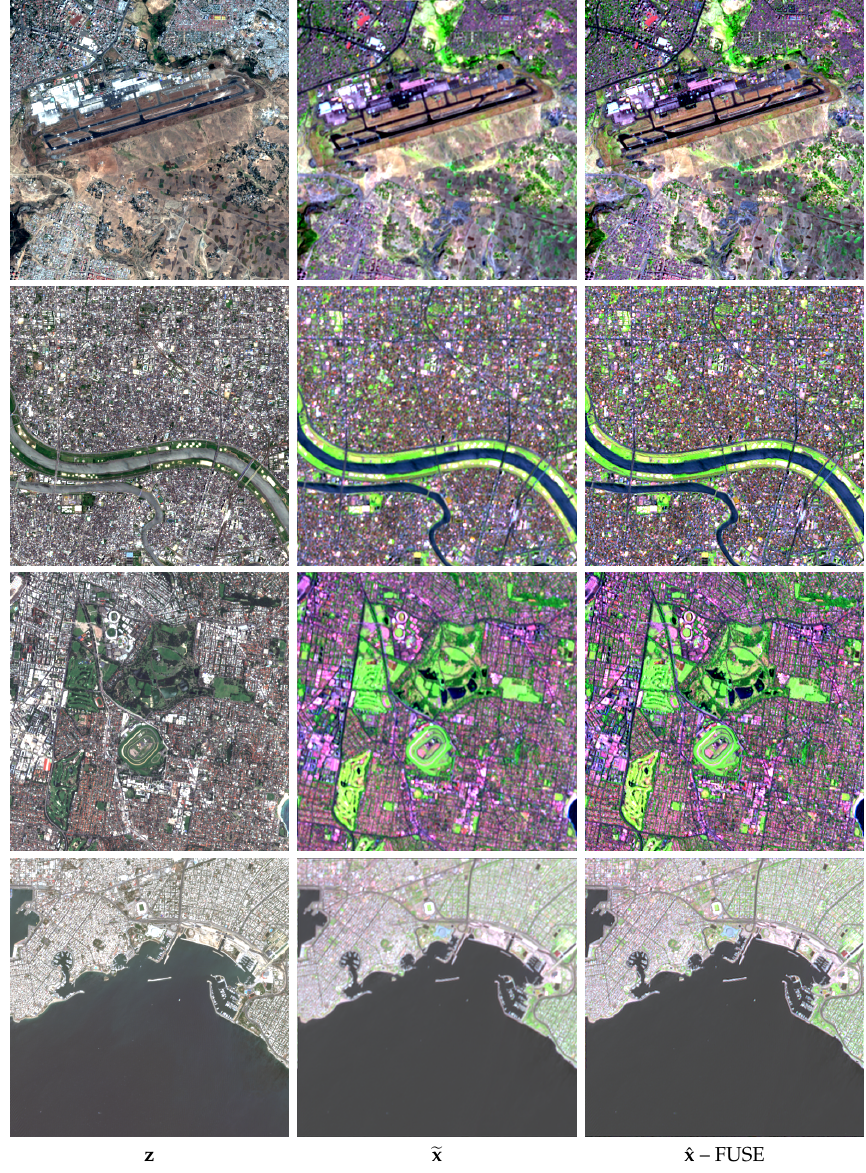
Figure 4. Super-resolution of the test images—Urban zones. From top to bottom: Adis Abeba, Tokyo, Sydney, and Athens. From left to right: High-resolution 10 m input component z , low-resolution 20 m x to be super-resolved, and super-resolution ˆ x using the FUSE component (cid:101)